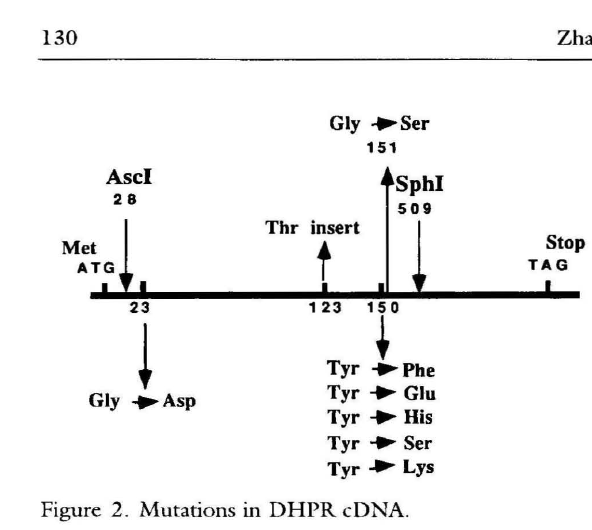
Figure 2. Mutations in DHPR